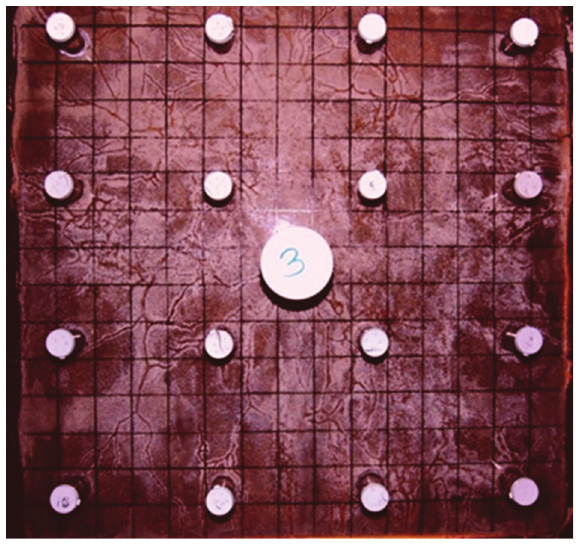
Figure 5: Coptotermes gestroi tunnels in foraging